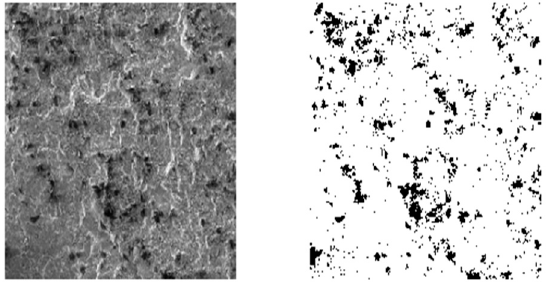
Figure 8. High–low loading fracture surface (520–420 MPa, n 1 /N 1 = 0.25) binarization. After binarization, the black pixels are in the form of dimples. According to statistics, the pixels in Figure 7 occupy the total selection area of S1 (0.921%), and the pixels in Figure 8 occupy the total selection area of S2 (9.79%). S2/S1 = 10.63. High–low loading signifi- cantly promotes the formation of dimples.